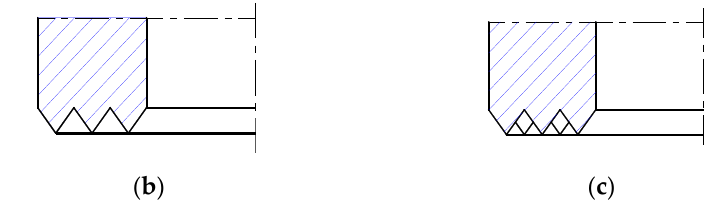
Figure 5. Schematic diagram of lip structure of diamond drill bit. ( a ) Bottom-flat shape; ( b ) Cusp concentric-circled shape; ( c ) Cusp-staggered shape.